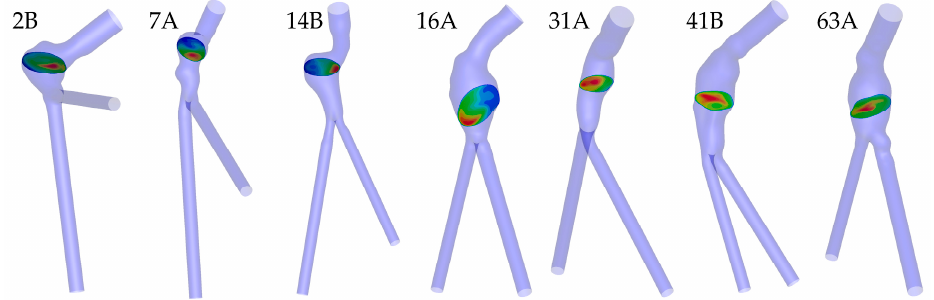
Figure 4. Patient-specific geometries and corresponding planes where flow asymmetry and dispersion were calculated.